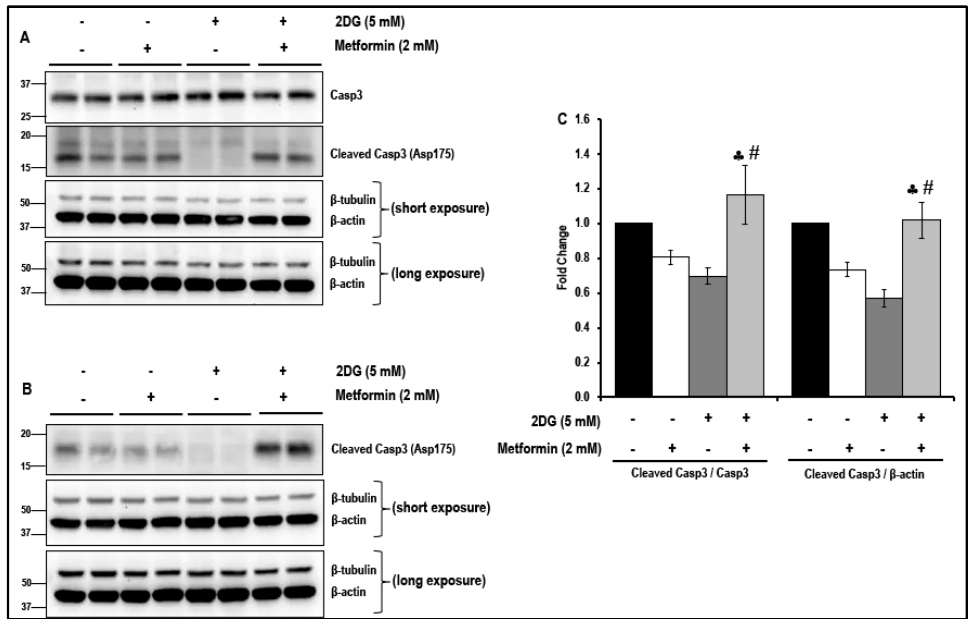
Figure 7. The levels of caspase-3 (Casp3) and cleaved caspase-3 in metformin-treated normal glucose- and 2DG-exposed MMECs (48 h): Representative Western blots, ( A ) shows the levels of total caspase-3 and cleaved caspase-3 (detected using the anti-caspase-3 antibody; Cat # 9665; Cell Signaling Technology, Danvers, MA, USA) and ( B ) shows the levels of cleaved caspase-3 (using the anti-cleaved caspase-3 antibody; Cat # 9664; Cell Signaling Technology, Danvers, MA, USA), in cells treated with 2DG (5 mM) in the presence or absence of metformin (2 mM), after 48 h in culture. Non-treated cells and cells treated with metformin (2 mM) alone were used as suitable controls. Bar graphs ( C ) represent the ratio of (normalized against β -actin loading controls) cleaved caspase-3/caspase 3 and cleaved caspase-3/ β -actin in the cells treated with 2DG (5 mM) with or without metformin (2 mM), after 48 h in culture. ♣ p < 0.05 indicates significance when compared to control + 2 mM metformin- treated cells and # p < 0.05 indicates significance when compared to 2DG (5 mM)-treated cells. 2.8. Treatment with a Combination of 2DG and Metformin Inhibits Cell Migration and Tubulogenesis in MMECs